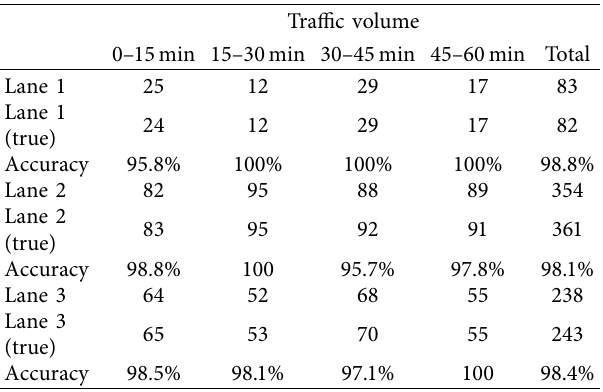
Table 2: Traffic volume detection by cooperative SRSs.